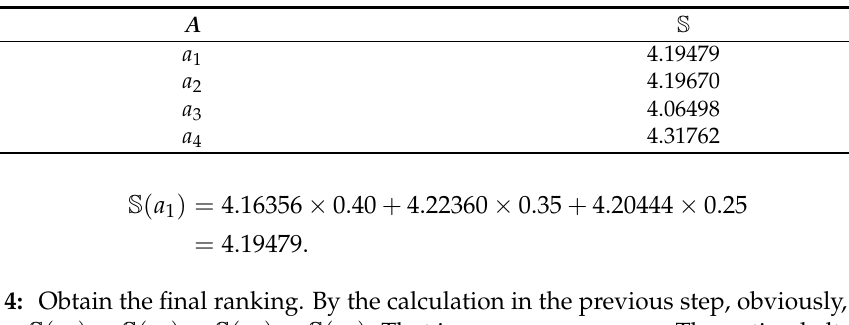
Table 8. Final evaluation score for all the